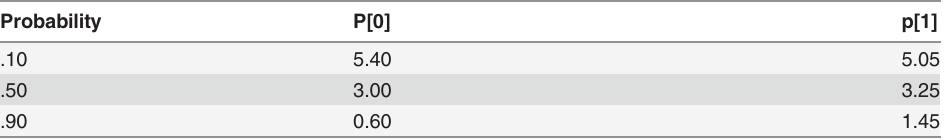
Table 3. Expected value of the high-uncertainty choice as a function of the probability of receiving 0 pellets (P[0]) or 1 pellet (P[1]) following a high-uncertainty choice in the high-uncertainty probability training procedure of Experiment